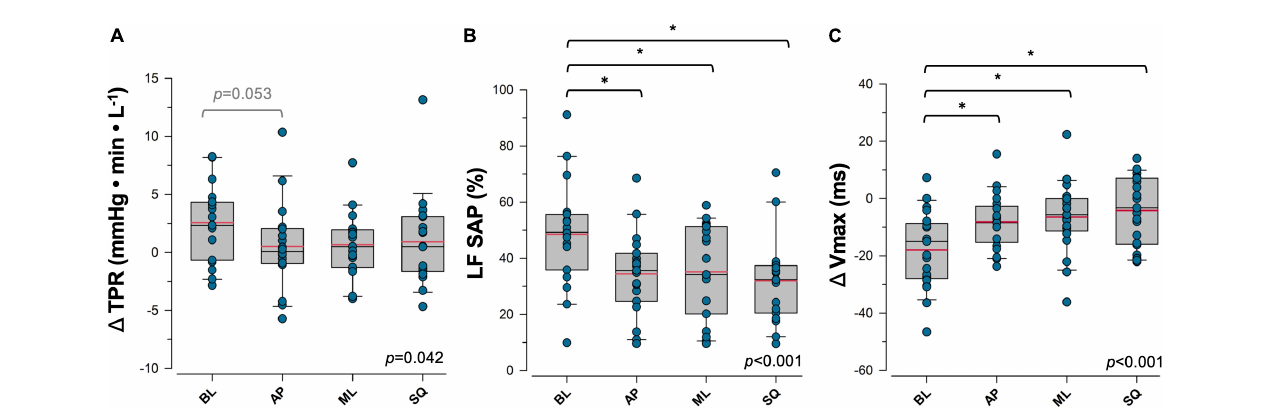
FIGURE3 Sympathetic response to postural sway. Responses to four patterns of sway in (A) total peripheral resistance (TPR), (B) percent power in low frequency systolic arterial pressure variability (LF SAP), and (C) maximum transvalvular ejection velocity (Vmax) are shown. Data for panels (A) and (C) are presented as the response during upright postural sway relative to supine rest. Main effects are indicated in the bottom right corner of each plot. *Significantly different from baseline ( p < 0.05). Trends that were approaching significance are given in grey. Red = sample mean, black = sample median. BL, baseline (quiet standing) sway; AP, anterior-posterior sway; ML, mediolateral sway; SQ: square sway.